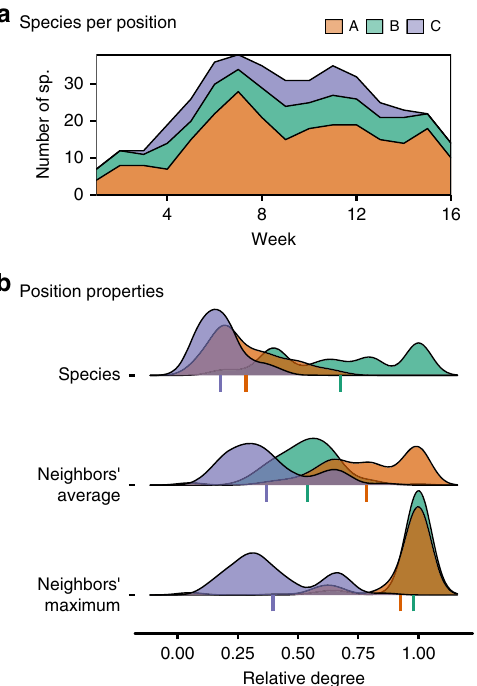
Fig. 3 Distinguishing properties of the distinct groups of pollinator positions. a Number of pollinator species in each group of positions over time. Each color represents a different group of positions. b Different properties summarizing the species forming each group. The top panel shows the relative degree distribution of species in each group. The middle panel shows the neighbors' average relative degree for the species in each group. The bottom panel depicts the relative degree distribution of the most connected neighbor of every species in each group. The colored segments depicted under the distributions characterize the mean of each distribution. The results displayed correspond to the 2015 sampling season, as this is the year for which we had the highest number of records. Similar results for the 2013 and 2014 sampling seasons can be found in Supplementary Figs. 3 and